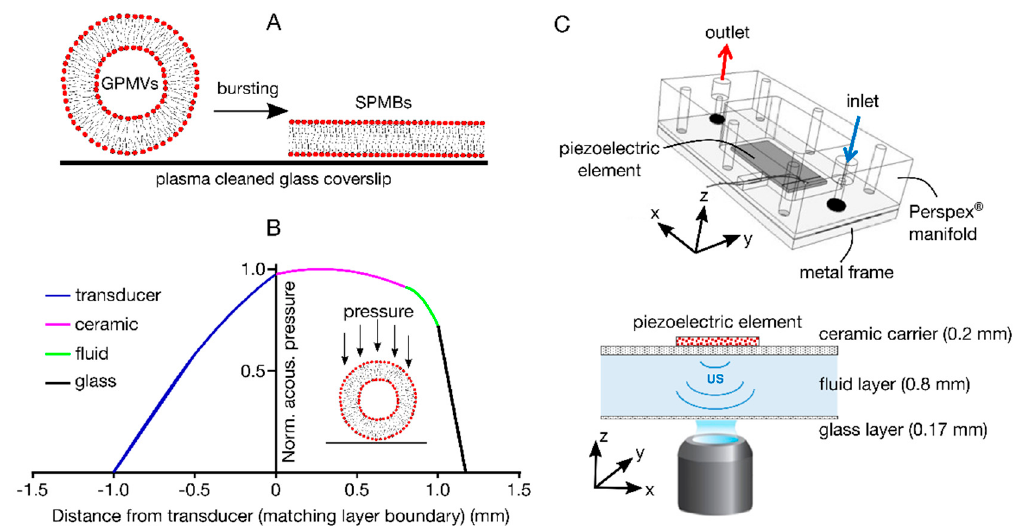
Figure 1. Overview of the experimental procedure. ( A ) Schematic of SPMB production from GPMVs. ( B ) Normalised acoustic pressure across the different layers of the device (at an operating frequency of 0.75 MHz), obtained from 1-D transfer impedance modelling. The device consisted of a 1 mm thick ultrasound generator (transducer, blue), a 0.8 mm thick ceramic carrier (red), a 0.2 mm thick chamber for the GPMV-containing fluid (green), and a 0.17 mm thick plasma cleaned microscope cover glass (black). Operating the device at its first thickness resonance generated a primary acoustic radiation force onto the GPMVs within the fluid, which was directed towards the glass surface (magenta area). ( C ) Top: Schematic representation of the acoustofluidic device assembly (isometric view), showing the Perspex ® manifold containing inlet/outlet ports, the metal frame, and the piezoelectric element generating the ultrasound (US) field. Bottom: Cross-sectional view of the piezoelectric element (US source), ceramic carrier layer, fluid layer, and glass coverslip. The thickness for each layer (in mm) is reported in brackets. These layers are kept in close contact with each other by screwing together the Perspex ® manifold and the metal frame.